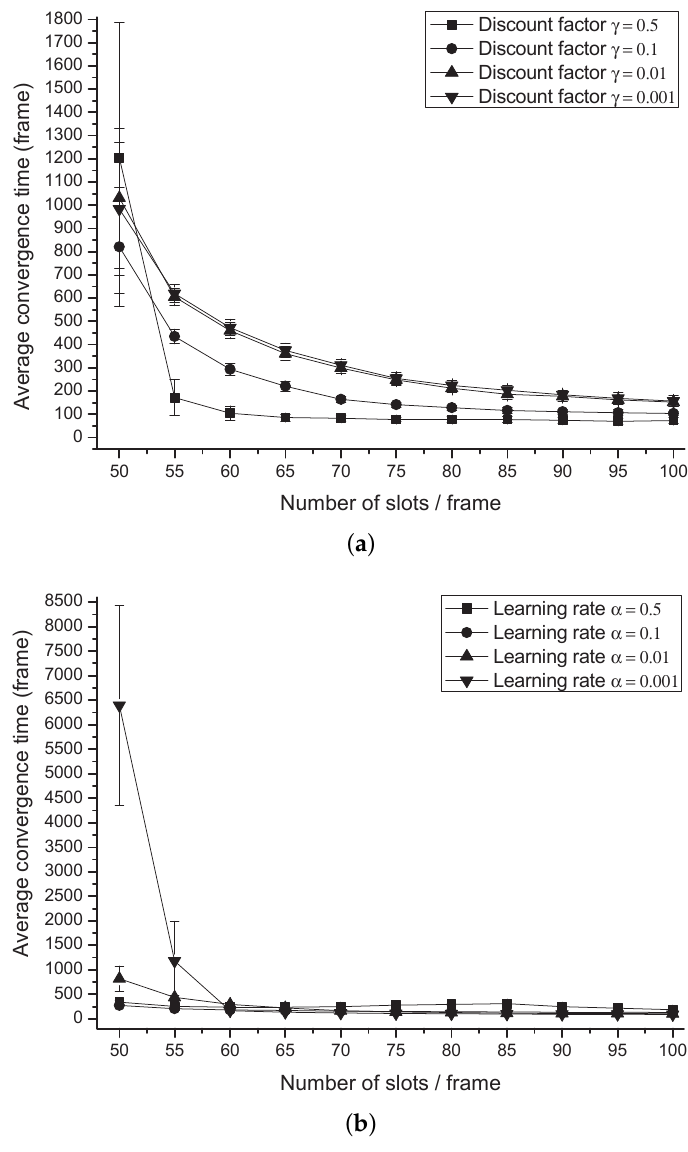
Figure 5. ( a , b ) Measures impact on convergence time of simulation parameters for deprioritized services by the networks. Networks of ( a ) change value of discount factor based on parameter setting of Table 1. Networks of ( b ) change value of learning rate based on parameter setting of Table 1. ( a ) Different discount factor γ . ( b ) Different learning rate α